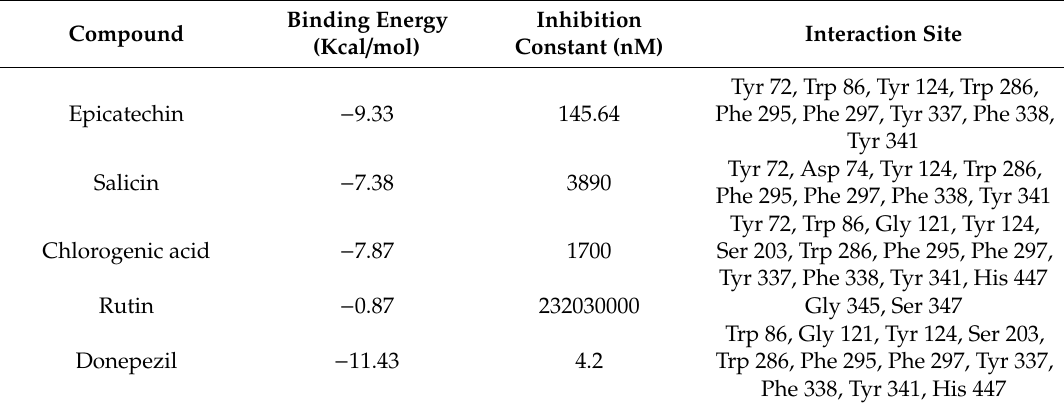
Table 5. Summary of molecular docking studies of selected compounds against acethylcholinesterase